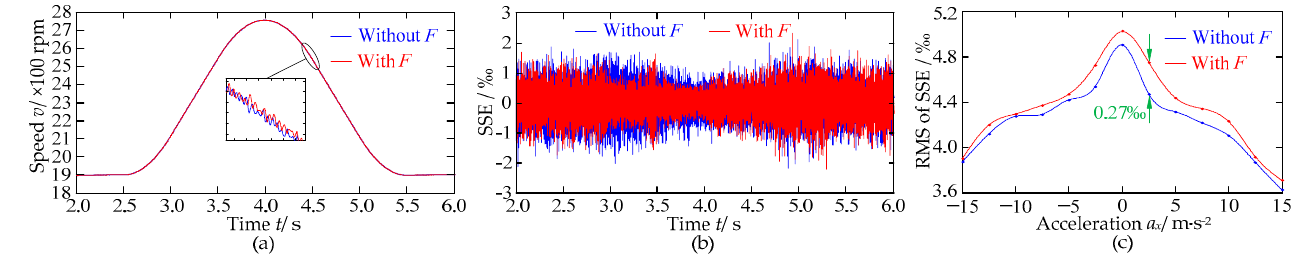
Figure 15. Speed and SSE when a x changes from 10 to − 10 m·s − 2 : ( a ) speed of PMSMs; ( b ) SSE; ( c ) the changes in RMS of SSE with a x .